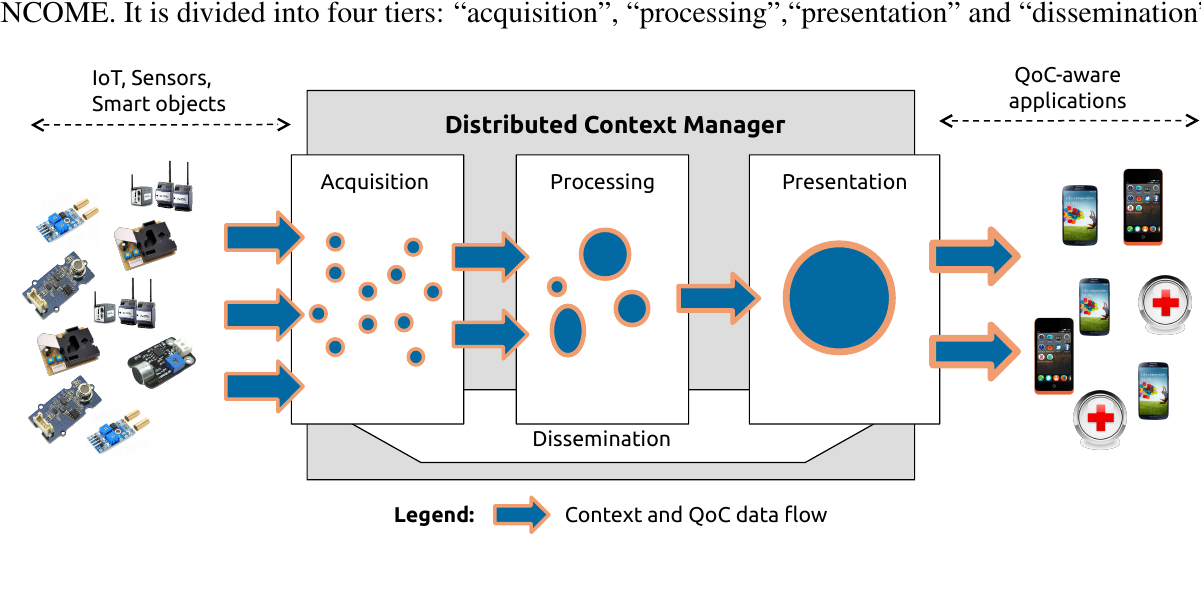
Figure 4. The main functionalities of a context